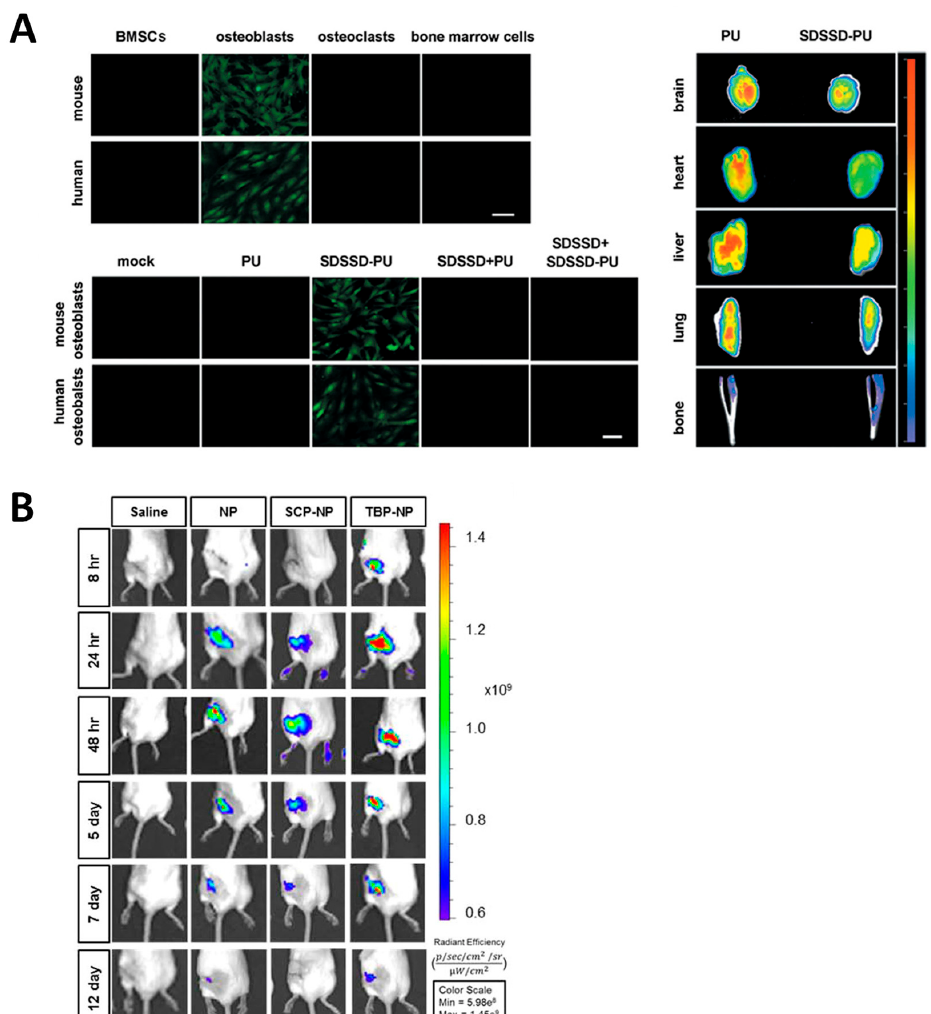
Figure 6. Representative images of nanocarriers targeted with peptides obtained through phage display. ( A ) Left: demonstration that SDSSD peptide targets osteoblasts over other cells. Right: biodistribution compared to the non-targeted NPs. ( B ) Biodistribution of TRAP-binding peptide- targeted NPs (TBP-NP) compared to different controls. Reproduced with permission from [74] (ACS Publications) and [97] (ACS